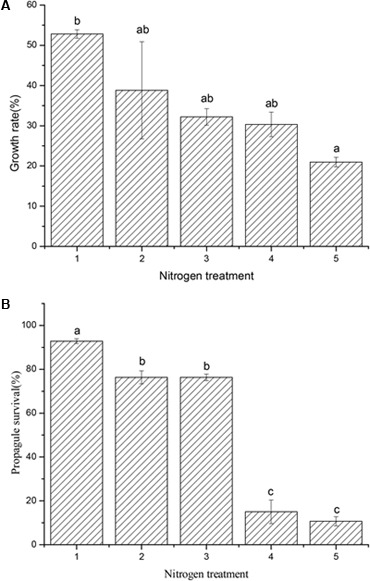
Effects of nitrogen addition on growth (A, n = 20) and propagule survival (B, n = 4) of Ramalina calicaris var. japonica. (A) code of horizontal axis represented 8.59, 14.24, 20.49, 32.99, and 57.99 kg N ha-1. y-1, respectively; (B) code of horizontal axis represented 0.0, 6.25, 12.5, 25.0, and 50.0 kg N ha-1 y-1, respectively. Vertical bars indicate standard deviation. Different lowercases indicate significant differences using the Tukey test (significance level at p < 0.05).